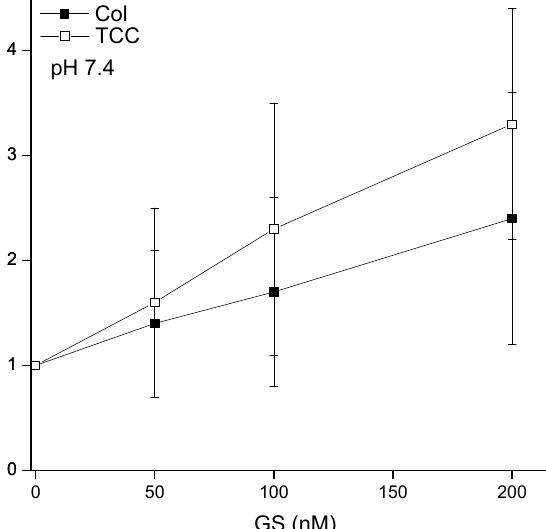
Figure 8. Liposome binding of CDs increases due to GS effects. The plots represent the liposome- bound CDs (normalized by the value of liposome-bound respective CD while the buffer was incu- bated with its 100 µ M concentration) as a function of various concentrations of GS that coexisted with 100 µ M CDs in the buffer. The concentration of lipids in the cuvette/buffer has been maintained for all investigations at [DOPC] = 1.145